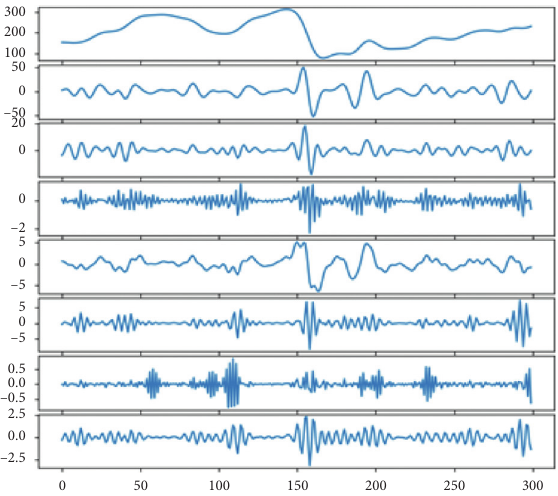
Figure 8: The decomposition result diagram of VMD. Table 4: The forecasting results of the original